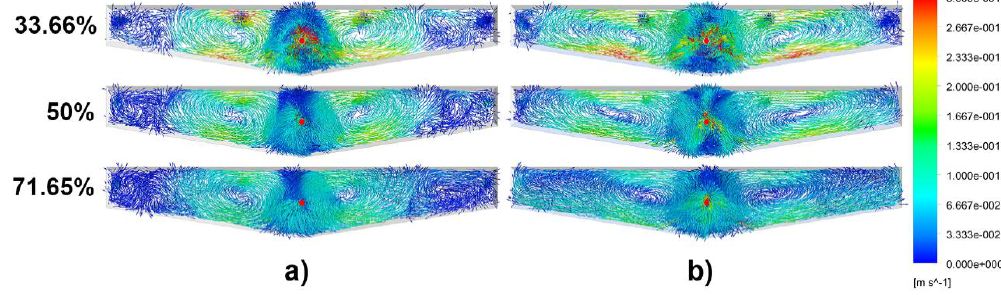
Figure 9. Velocity fields at different height percentages of the total bath level during operation of the tundish: ( a ) TI1; ( b ) TI3.